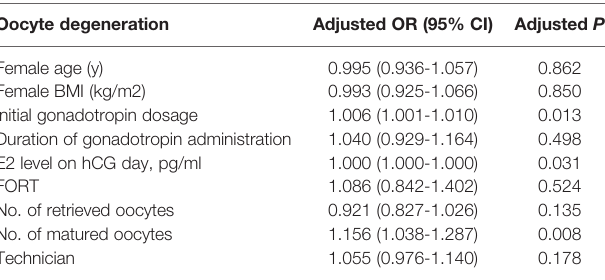
TABLE 2 | Multiple logistic regression analysis of oocyte degeneration to account for confounding variables. Oocyte